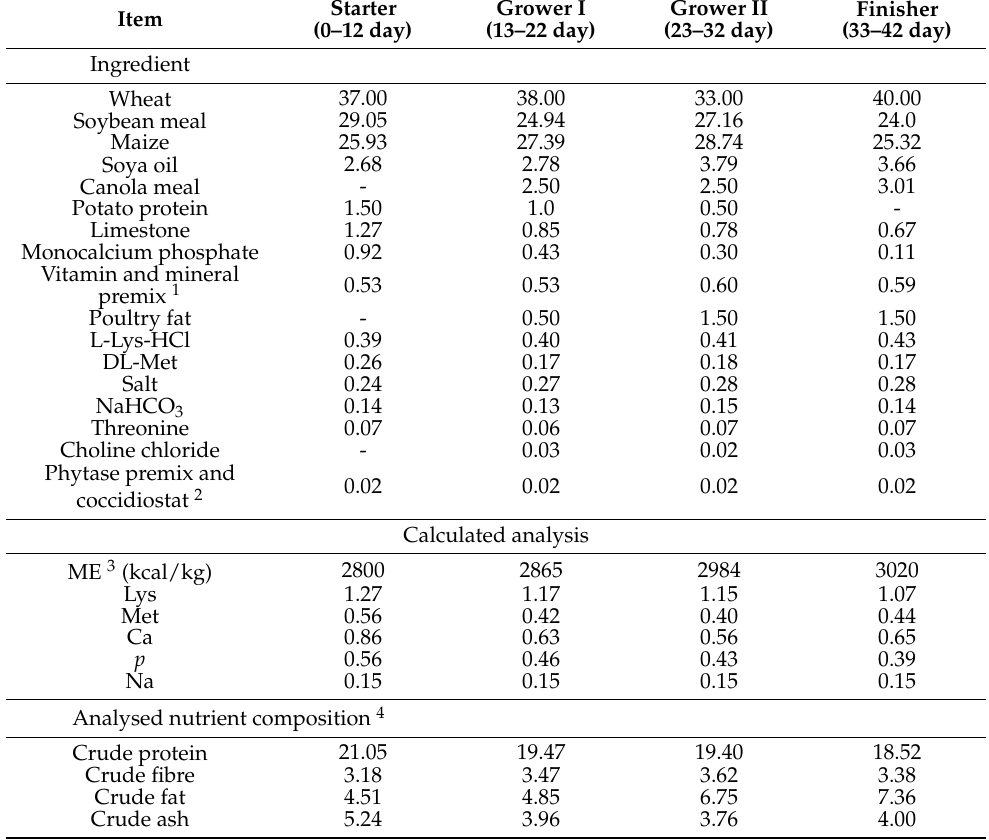
Table 1. Ingredient and nutrient composition of the basal diets